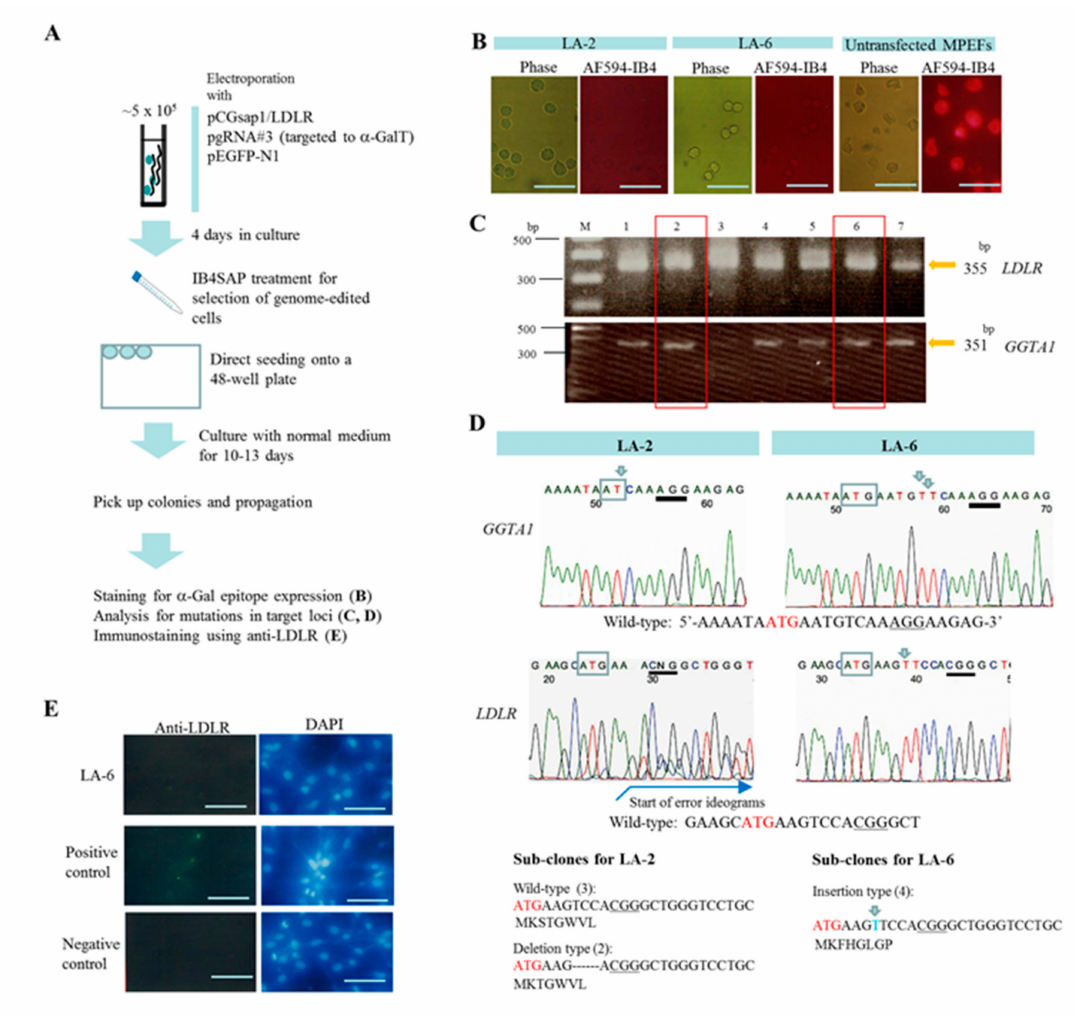
Figure 2. ( A ) Flowchart of the experiments used for testing the feasibility of the new system for enrichment of cells genome-edited at a single target locus. Four days after transfection with pCGsap1/LDLR, pgRNA#3, and pEGFP-N1, cells were treated with IB4SAP for a short period and cultured in normal medium for more than 10 days. The emerging colonies were propagated for molecular biological and cytochemical analyses; ( B ) cytochemical staining of clones LA-2 and -6 with AF594-IB4. Untransfected MPEFs were stained as positive control. Phase, photographs taken under light microscopy; AF594-IB4, photographs taken under UV illumination to detect AF594-IB4--derived red fluorescence. Bar = 30 µ m; ( C ) electrophoretic pattern of polymerase chain reaction (PCR) products derived from the amplification of LA-1 to -7. Arrows indicate the size of PCR products for each gene ( LDLR and GGTA1 ). M, 100 bp-ladder markers; ( D ) direct sequencing of PCR products from LA-2 (left panel) and LA-6 (right panel) using primers specific to LDLR or GGTA1 gene. Arrows above ideograms indicate the sites showing indels. In the bottom of each panel, sequencing results of inserts sub-cloned into TA cloning vector are shown. The numbers of clones examined are shown in parentheses. The translation initiation codon ATG is shown by boxes or in red. PAM is indicated by underlines. The deleted portion in the clones is shown by dotted lines; ( E ) immunocytochemistry of LA-6 and intact MPEFs (used as positive control) using anti-LDLR antibody. The parental MPEFs reactive to the second antibody (fluorescein-labeled anti-mouse IgG) alone are designated as negative control. All cells were counterstained with DAPI upon reaction with the second antibody. Bar = 30 µ